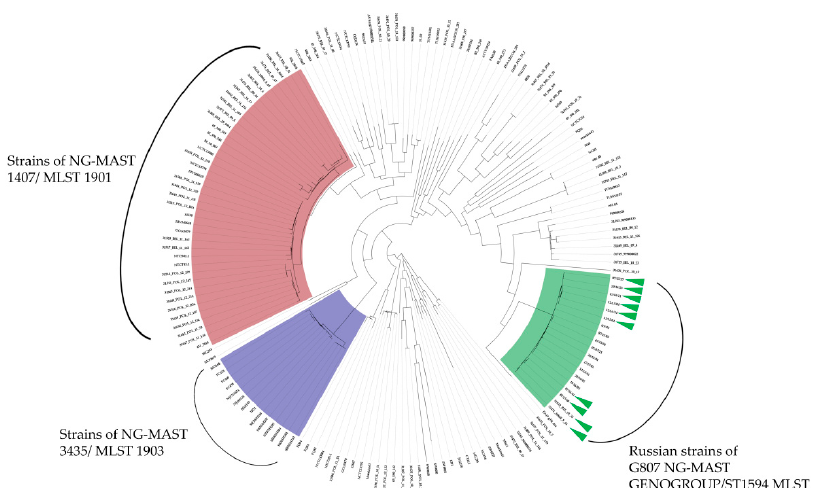
Figure 3. Phylogenetic analysis of the global diversity of N. gonorrhoeae was performed using the Maximum likelihood algorithm in Parsnp 1.6. Green triangles mark the Russian strains of the G807 NG-MAST GENOGROUP/ST1594 MLST with biochemical atypia, the cluster of strains from Asian countries are represented by the clones of strain FC428 of the NG-MAST 3435/MLST 1903 and strains of the NG-MAST 1407/MLST 1901 isolated in European countries.